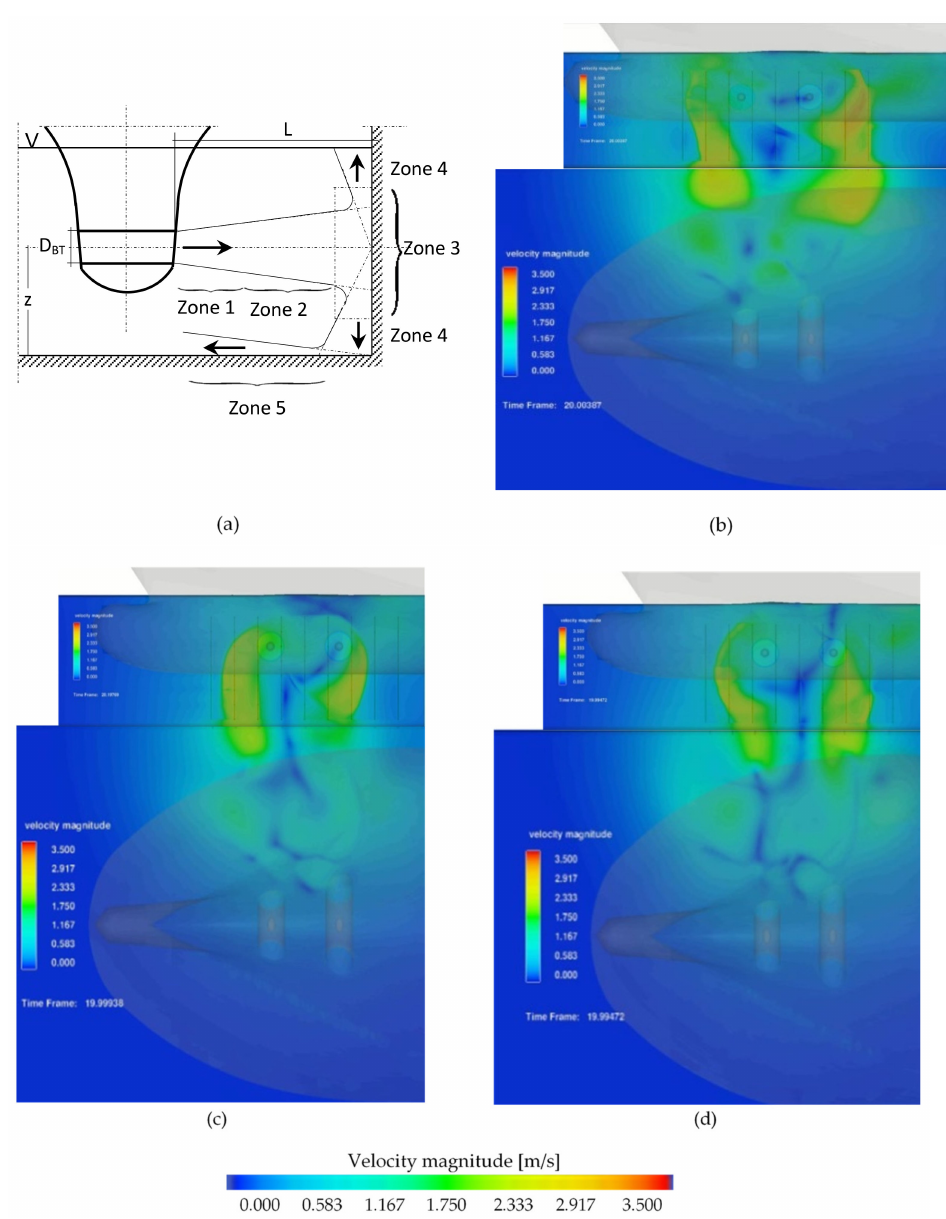
Figure 11. Bow thruster-generated flow distribution: ( a ) 5 zones of flow proposed by Schmidt cited in [8]; ( b – d ) CFD simulation—image of the highest velocity on the quay wall and on the seabed for both the bow thrusters operating with the thrusts equal to 105 kN, 130 kN and 160 kN during the period of time of 10 s,